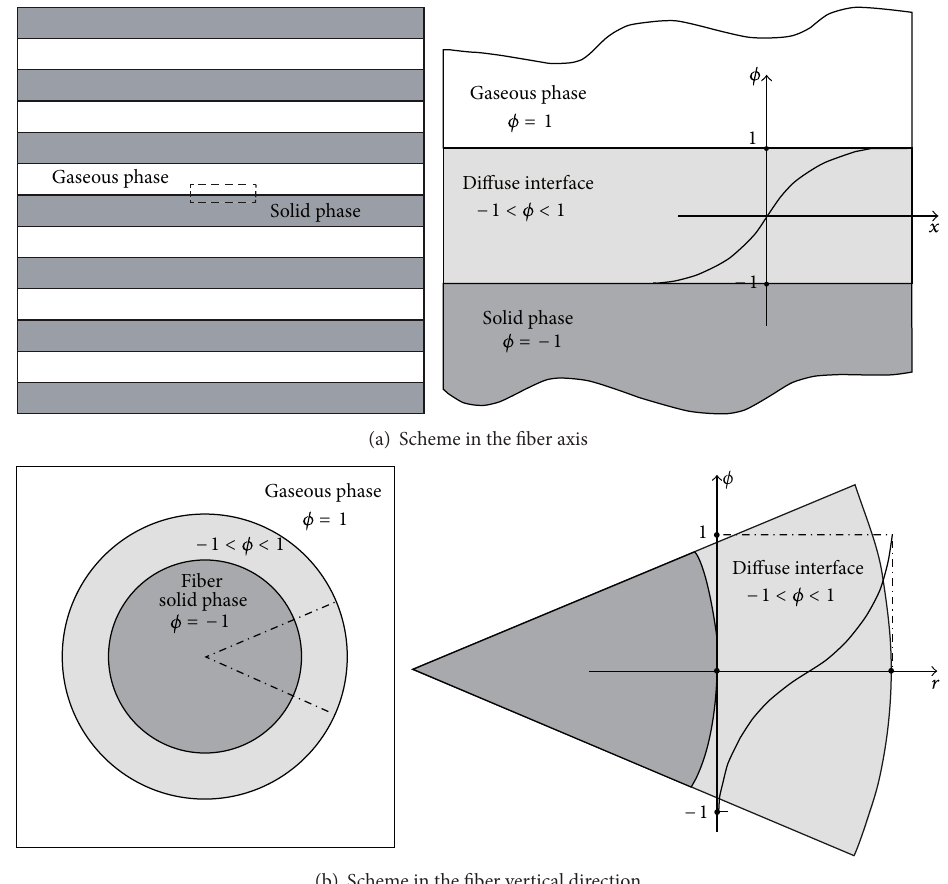
(b) Scheme in the �ber vertical direction F 2: Schematic illustration of the de�nition of the phase �eld parameter